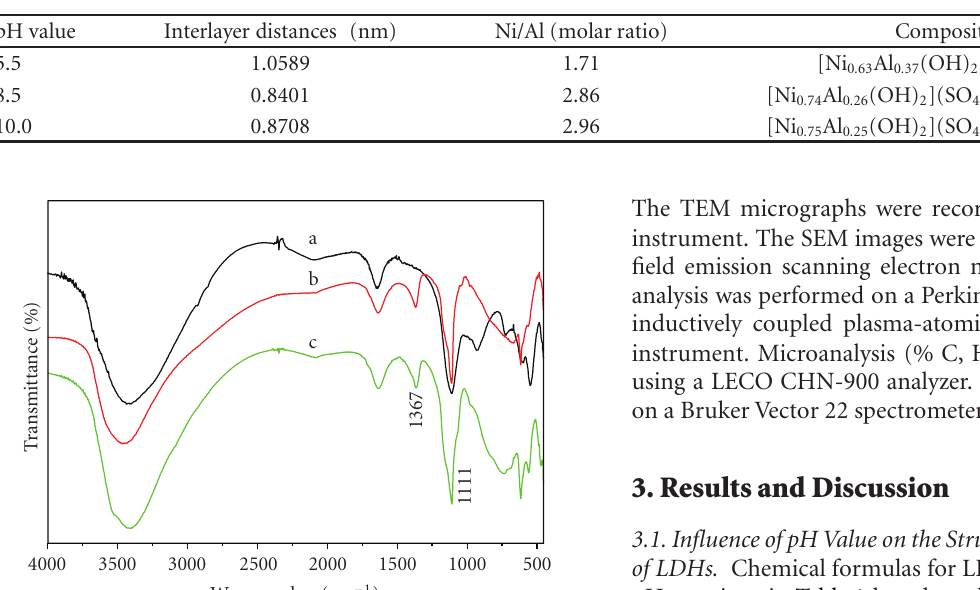
Table 1: Chemical formulas and interlayer distances of Ni/Al LDH prepared at di ff erent pH values.